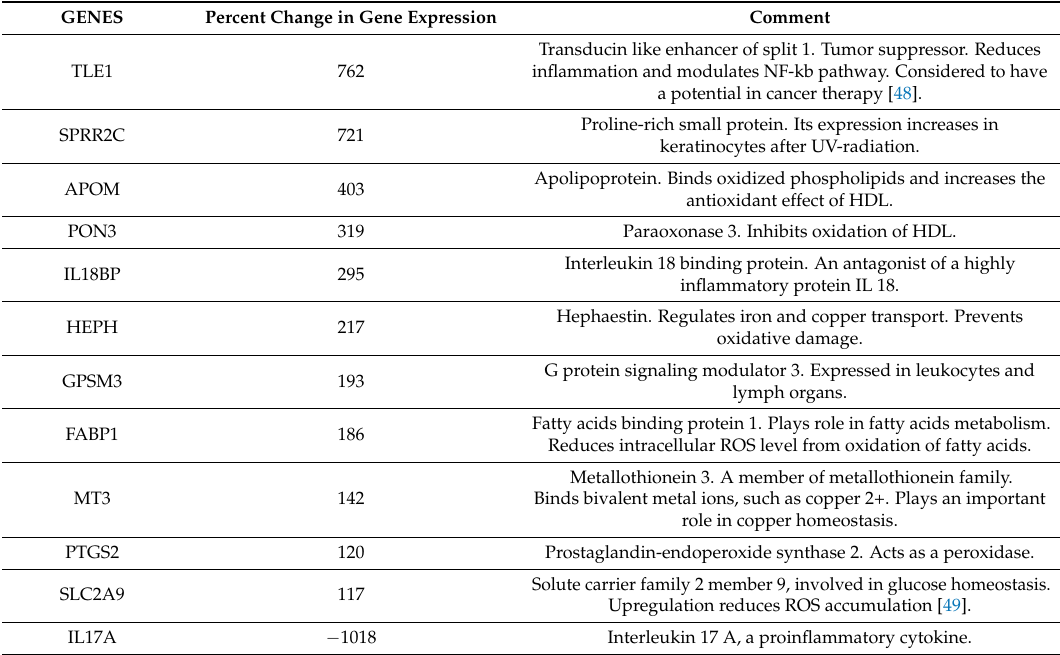
Table 6. GHK effect on genes related to antioxidant